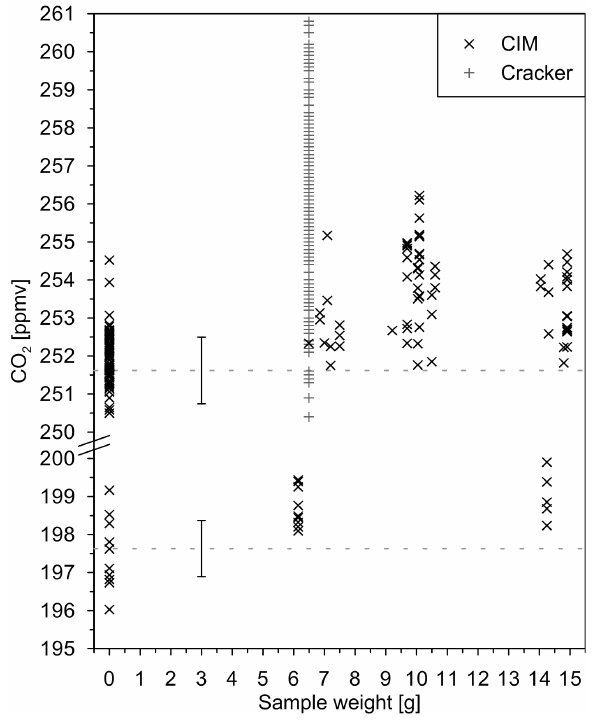
Fig. 4. Measurement results of the CIM system (black crosses) and cracker system (grey crosses) using standard gas with 251.62ppmv (upper dashed line) and 197.63ppmv (lower dashed line) CO 2 con- centration and gas-free single-crystal ice samples. In the case of the CIM different sample weights have been used. For both stan- dard gases an error (1 σ ) for the single CIM data point is given by the error bars initiated at 3g sample weight (SIO197: ± 0.74ppmv SIO251 ± 0.88ppmv). They represent the standard deviations of all data points of the corresponding standard gas shown in this figure. To calculate these deviations, in a first step all results from sam- ples with weights > 0 were corrected for their mean offset to the corresponding standard value.